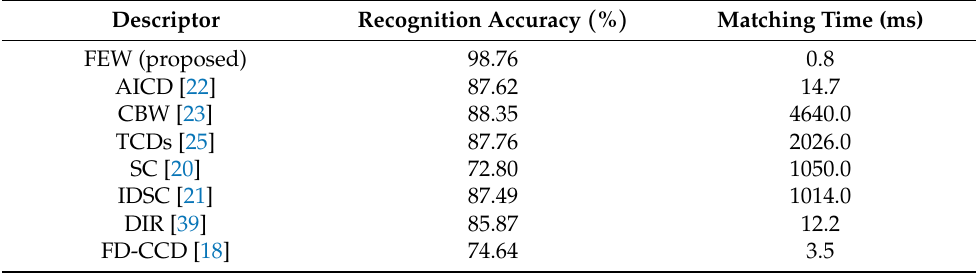
Table 2. Comparison of performance on FEW 100